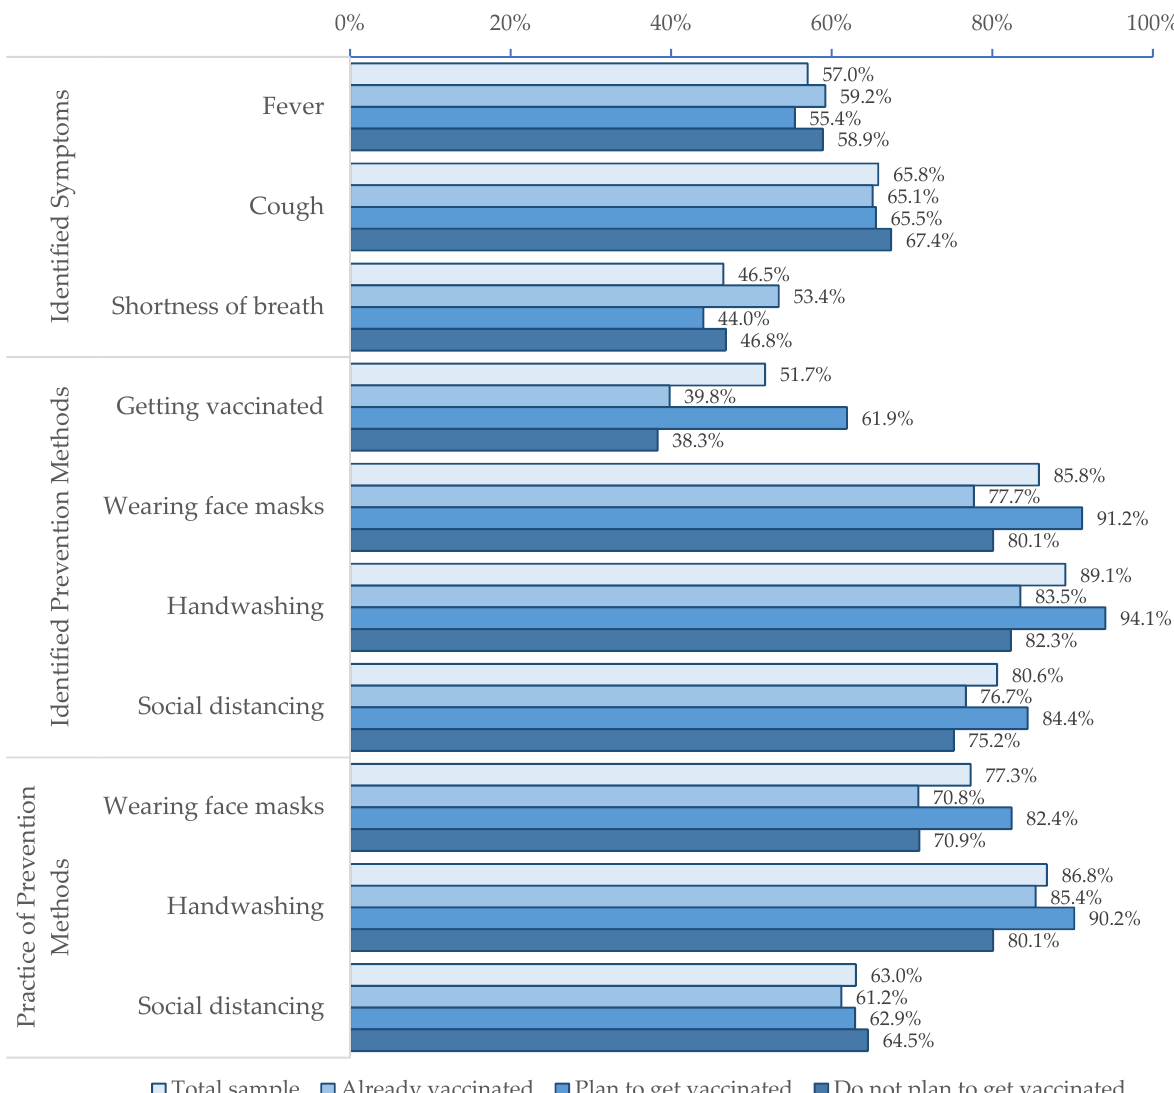
Figure 1. Knowledge, attitudes, and behaviors regarding COVID-19 and the COVID-19 vaccines, categorized by vaccina- tion status.